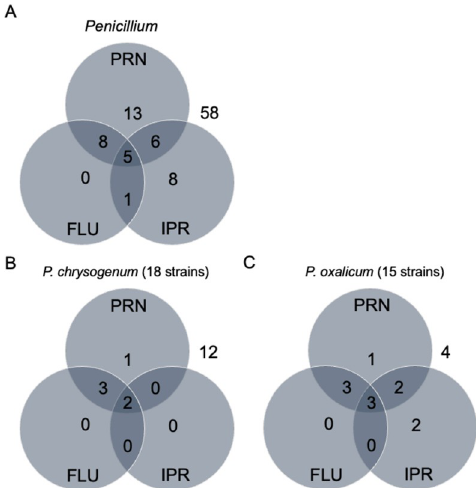
Fig 4. Multi-drug resistance to pyrrolnitrin, fludioxonil, and iprodione. Venn diagrams of the numbers of pyrrolnitrin-, fludioxonil-, and iprodione-resistant strains in Penicillium species (A) , P . chrysogenum (B) , and P . oxalicum (C) . PRN, pyrrolnitrin; FLU, fludioxonil; and IPR,